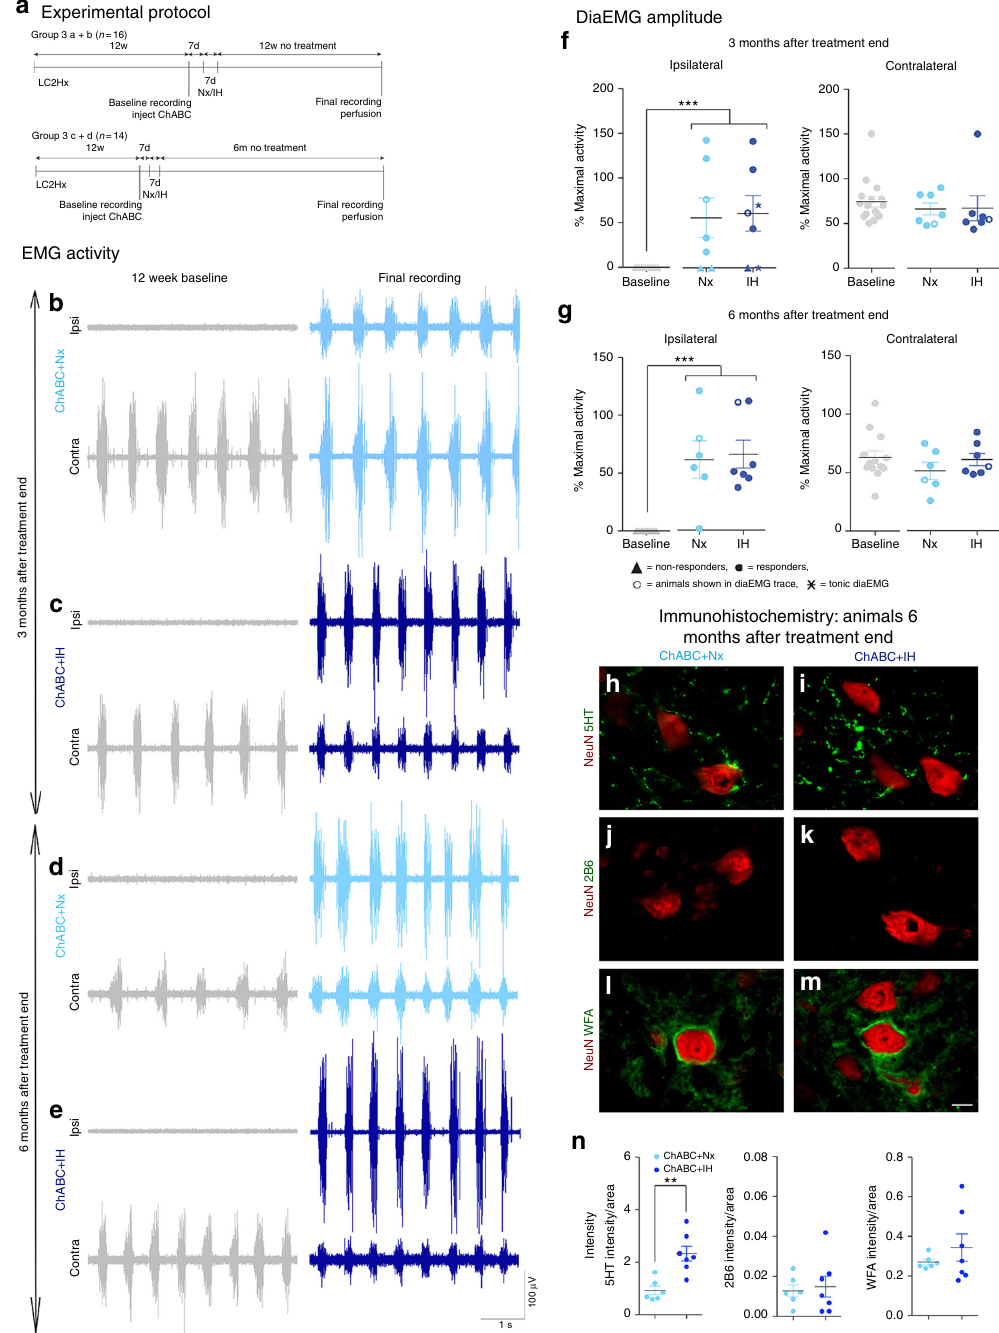
Fig. 3 Respiratory recovery is maintained up to 6 months after PNN digestion. a Experimental protocol. b – e DiaEMG recordings at baseline and after treatment. Animals received ChABC and air (Nx) or IH conditioning and were housed for b , c 3 months or d , e 6 months without treatment. Data panels presented from the same animal. f , g Average amplitude of f 3 month and g 6 month animals diaEMG. Filled circles = responders; un fi lled circles = animals in b – e ; triangles = non-responders; stars = tonic activity shown. For b – g n = 6/7 per group, baseline n = 13/14. h – n Immunohistochemistry and intensity readings at the ipsilateral C4 PMP utilizing NeuN (red) and either (green) h , i 5HT; j , k 2B6; or l , m WFA 6 months after treatment ( n = 6/8 per group). For all EMG or graph panels, treatment groups = baseline (grey); ChABC + air (light blue); ChABC + IH (blue). ** p < 0.01 and *** p < 0.001. If no post-hoc result is shown, comparison was not-signi fi cant. Scale bar = 50 μ m. For all panels: values represent mean ± SEM fi ring that did not dissipate until the neuromodulator had likely was tonic? We applied 5HT to a subset of ChABC + IH-treated animals that displayed recovery of synchronized ipsilateral been metabolized. Further, in all animals that exhibited tonic hemidiaphragm activity (Fig. 4m; n = 7; 5 systemic applications, ipsilateral activity ( n = 6; 4 systemic applications, 2 direct 2 direct injections). Following application, in all animals the injections), application of a 5HT2c/a antagonist blocked the ipsilateral hemidiaphragm rapidly developed tonic motor unit abnormal motoneuron fi ring revealing respiratory activity NATURE COMMUNICATIONS| (2018) 9:4843 |DOI: